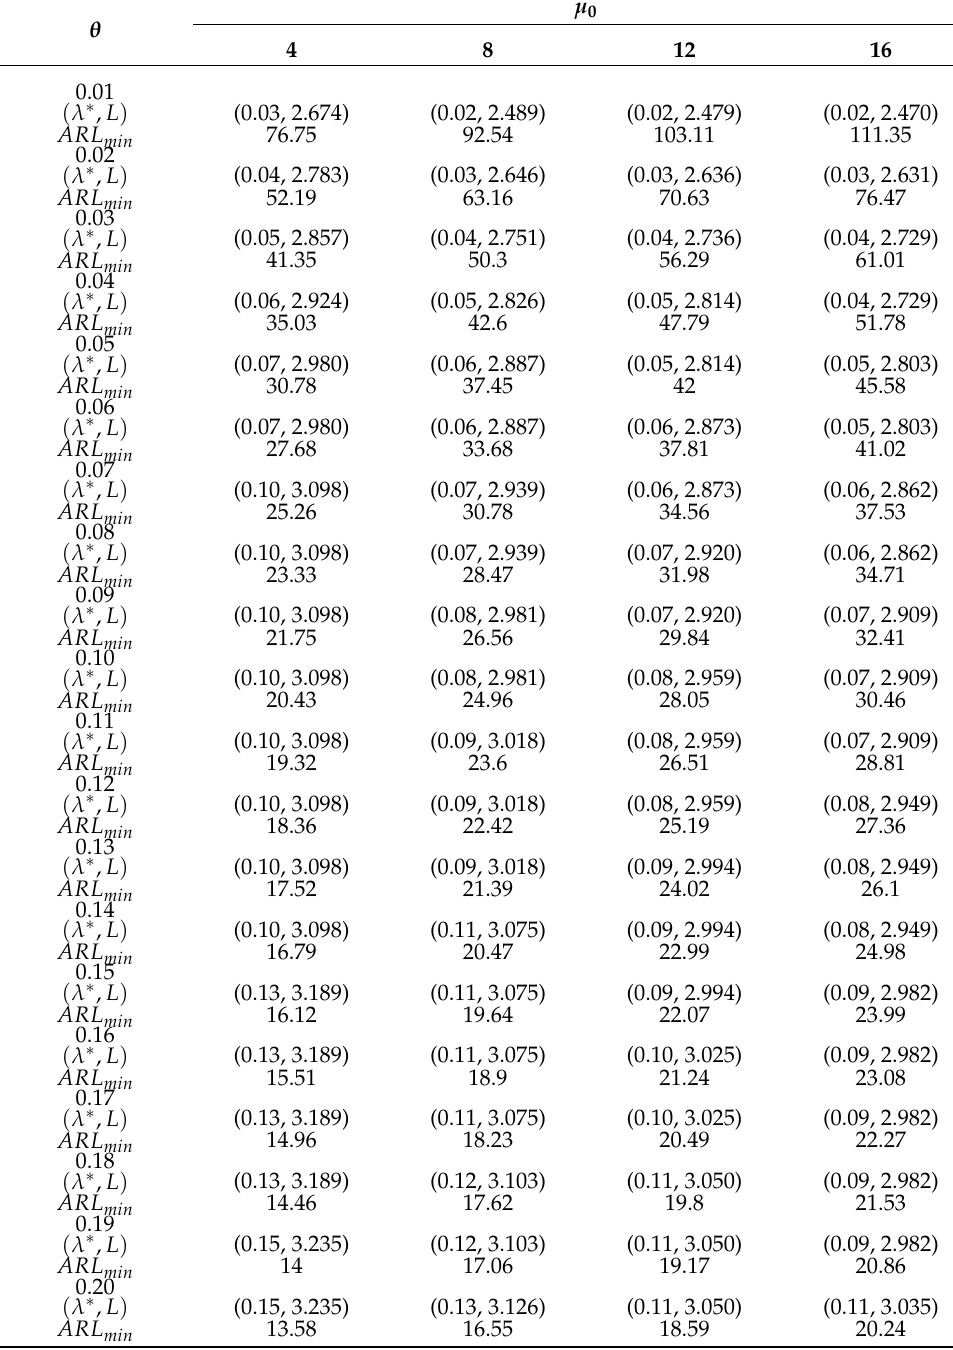
Table 5. Optimal parameters for the EWMA chart when ARL 0 =